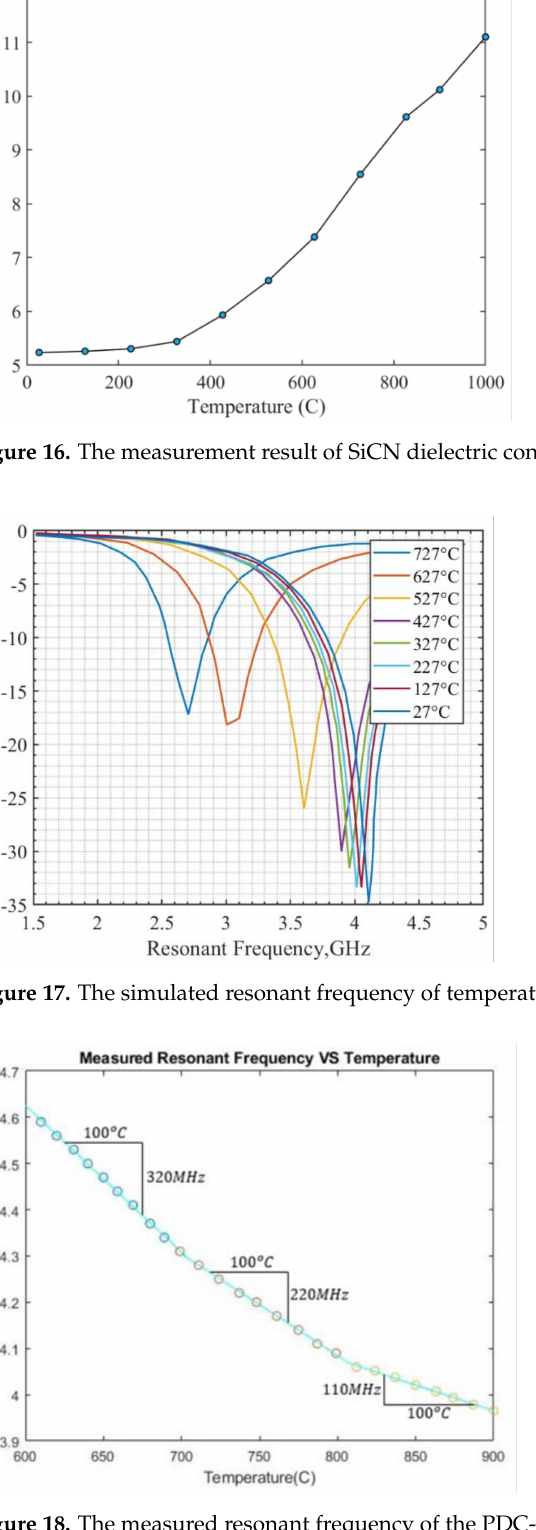
Figure 18. The measured resonant frequency of the PDC-SiCN patch temperature sensor at various ambient